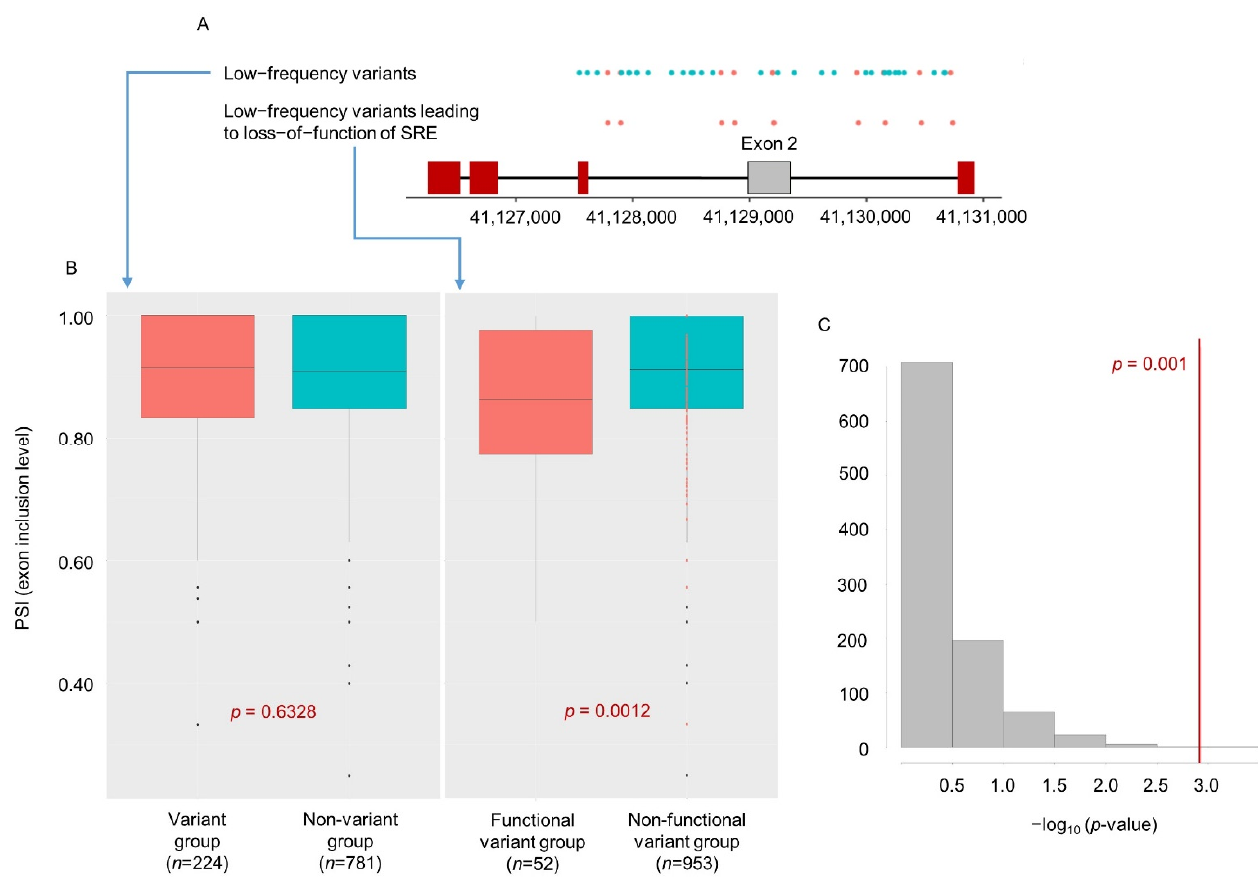
Figure 4. ( A ) Schematic of TREM2 exon positions and low-frequency variants found within exon 2, flanking introns, and neighboring exons. ( B ) Distribution of PSI values among groups defined according to the presence and predicted splicing functionality of low-frequency variants. The left boxplot compares the variant and non-variant groups with the variant group comprising all samples with low-frequency variants (the blue and red dots in A ); the right boxplot compares the functional variant group, samples with low-frequency variants leading to loss of SRE function, and the non-functional variant group, samples with either no variants or low-frequency variants not leading to loss of SRE function. There was no significant difference in PSI between the variant and non-variant groups (left boxplot), but a difference was found between the functional and non-functional variant groups (right boxplot). Red points in the right boxplot indicate the samples having low-frequency variants not leading to loss of SRE function (i.e., samples in the variant group but not the functional variant group). ( C ) Histogram of p -values generated from 1000 random permutations selecting samples ( n = 52) to constitute the functional variant group. Only five instances obtained with random selection were the p -values less than our original result (i.e., 0.0012).